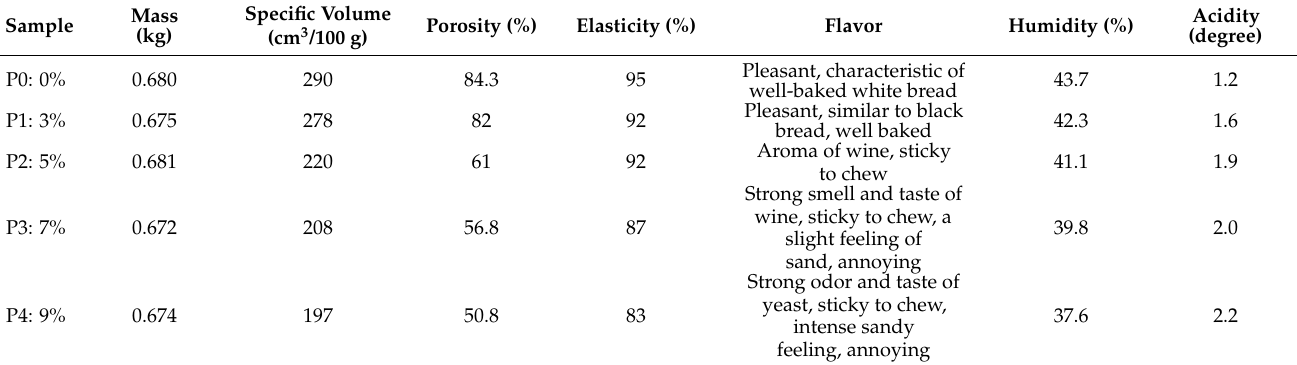
Table 9. Physicochemical indicators of experimental breads with the addition of